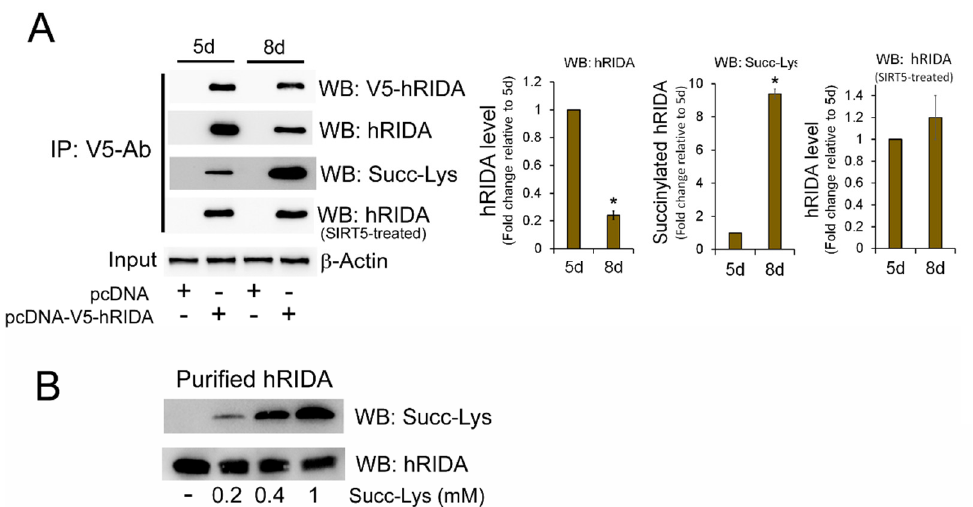
Figure 2. Exogenous V5-tagged hRIDA was differently K-succinylated in high and low proliferating cells. ( A ) High and low proliferating HEK293 cells were transfected with pcDNA-V5-hRIDA or the empty vector pcDNA, at 4d and 7d after seeding the cells. The next day, cells were lysed, and V5-hRIDA was immunoprecipitated from protein extracts using V5 epitope antibody. Immunoprecipitated proteins were fractionated on 15% SDS-PAGE, transferred onto a nitrocellulose membrane and immunodecorated with antibodies against the V5 epitope (WB: V5-hRIDA), hRIDA (WB: hRIDA) and succinyl-lysine (WB: Succ-Lys). V5-hRIDA was in vitro desuccinylated with SIRT5, then transferred onto a nitrocellulose membrane and immunodecorated with the antibody against hRIDA (WB: hRIDA, SIRT5-treated). Chemiluminescence signals were normalized with respect to the β -actin in input protein extracts. Normalized values were reported in the histograms as fold change with respect to the cells at day 5. ( B ) Recombinant purified hRIDA was in vitro succinylated with different concentration of succinyl-CoA, fractionated on SDS-PAGE, transferred onto a nitrocellulose membrane and immunodecorated with antibodies against succinyl-lysine ( B , upper panel) and hRIDA ( B , lower panel). Values are means ± S.D. of three independent experiments. *, value significantly different from the control, p < 0.05.